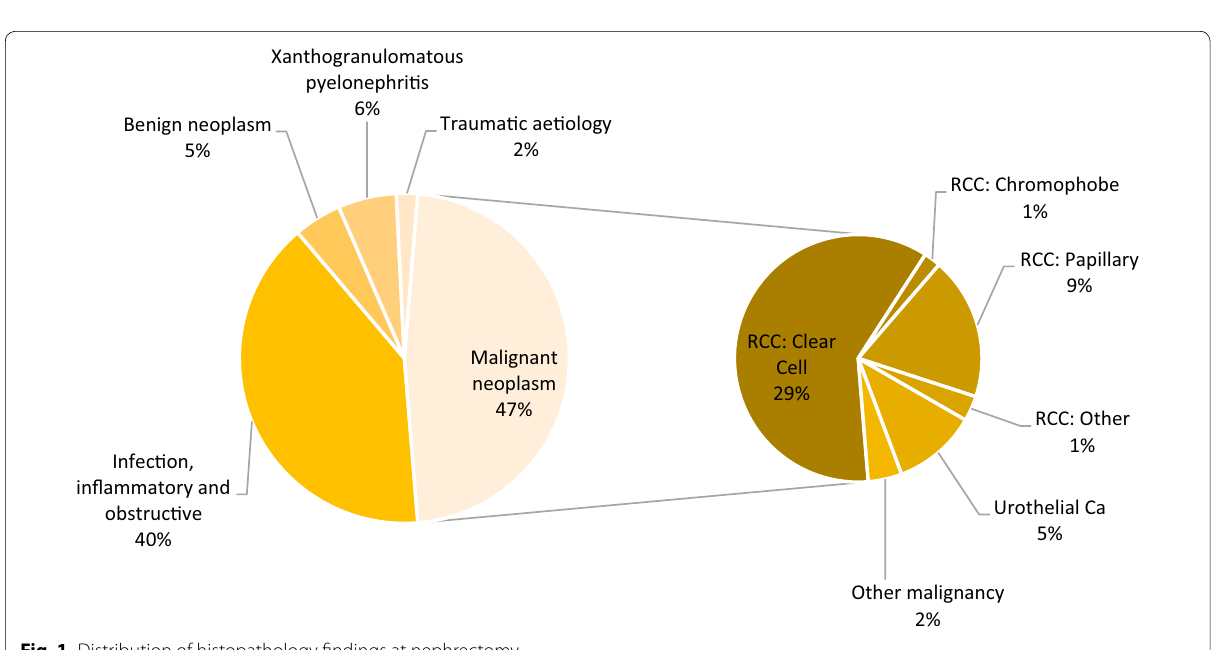
Fig. 1 Distribution of histopathology findings at